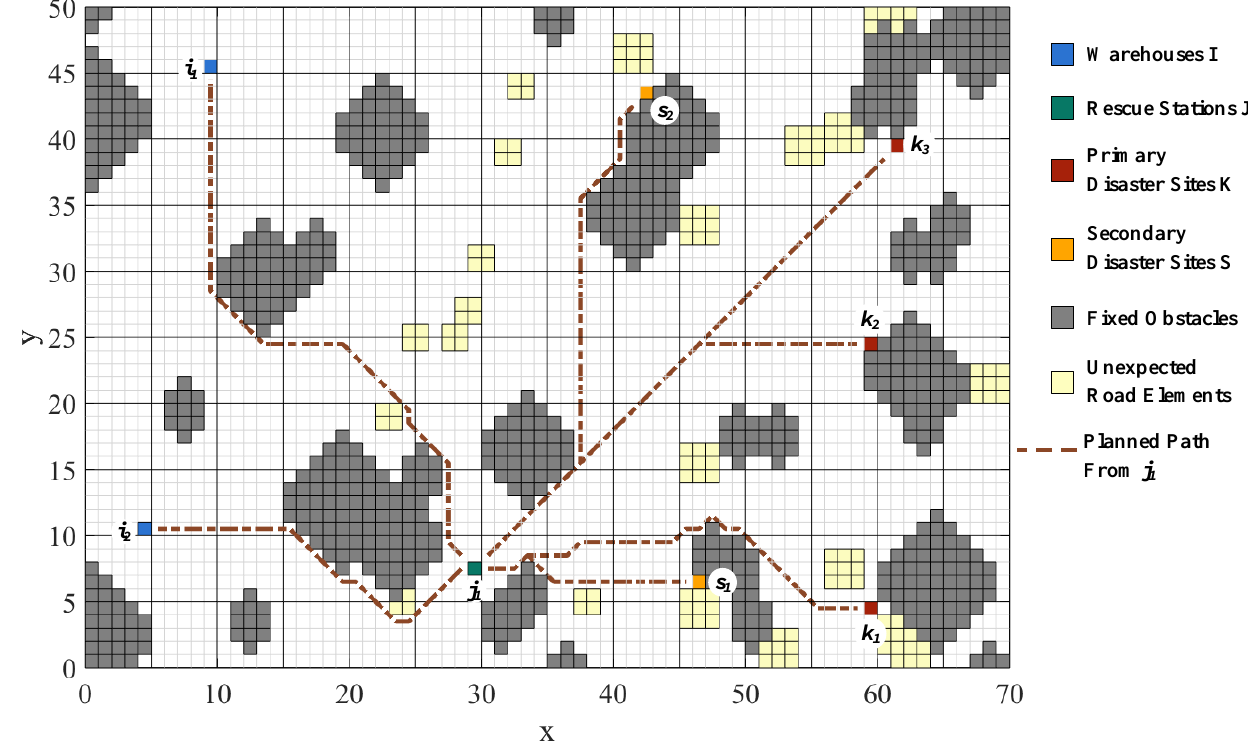
Figure 3. Paths from Rescue Station j 1 to each